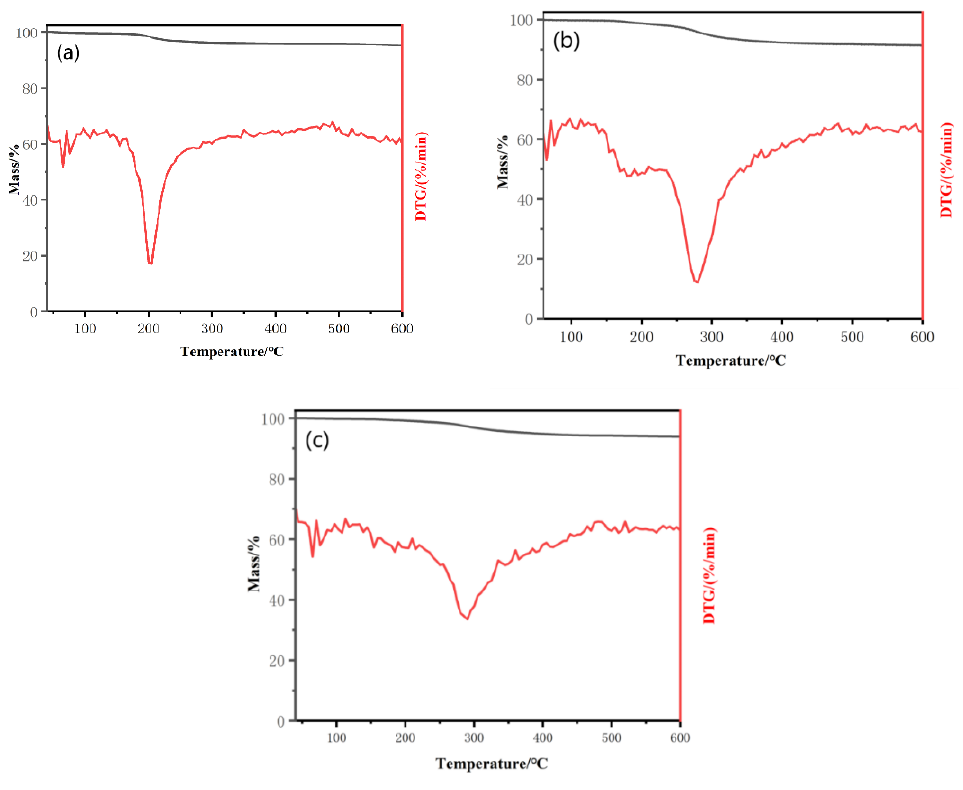
Figure 7. Thermogram of catalysts ( a ) fresh 5 wt.% Pd(OH) 2 /C catalyst treated with acetic acid; ( b ) 5 wt.% Pd(OH) 2 /C catalyst after reaction; and ( c ) 5 wt.% Pd(OH) 2 /C catalyst recovering with chloroform and glacial acetic acid.